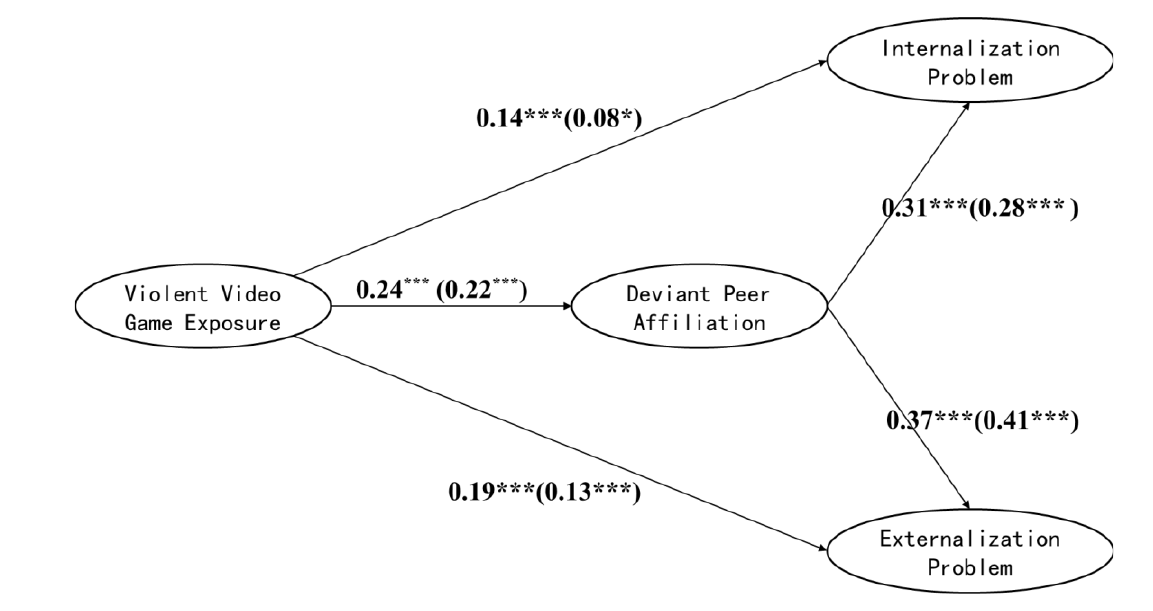
Figure 2. Gender differences in mediating role of deviant peer affiliation. Note: The path coefficient is male outside the brackets and female inside the brackets; the load coefficient between each latent variable and its index, the residual error and error of all variables, and the control variable coefficient are omitted to simplify the model. * p < 0.05, *** p < 0.001.